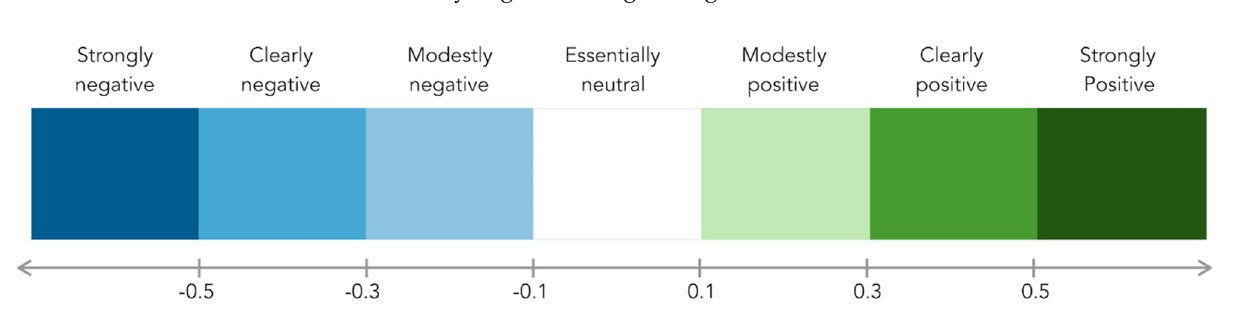
Figure 2. Sentiment score classification.